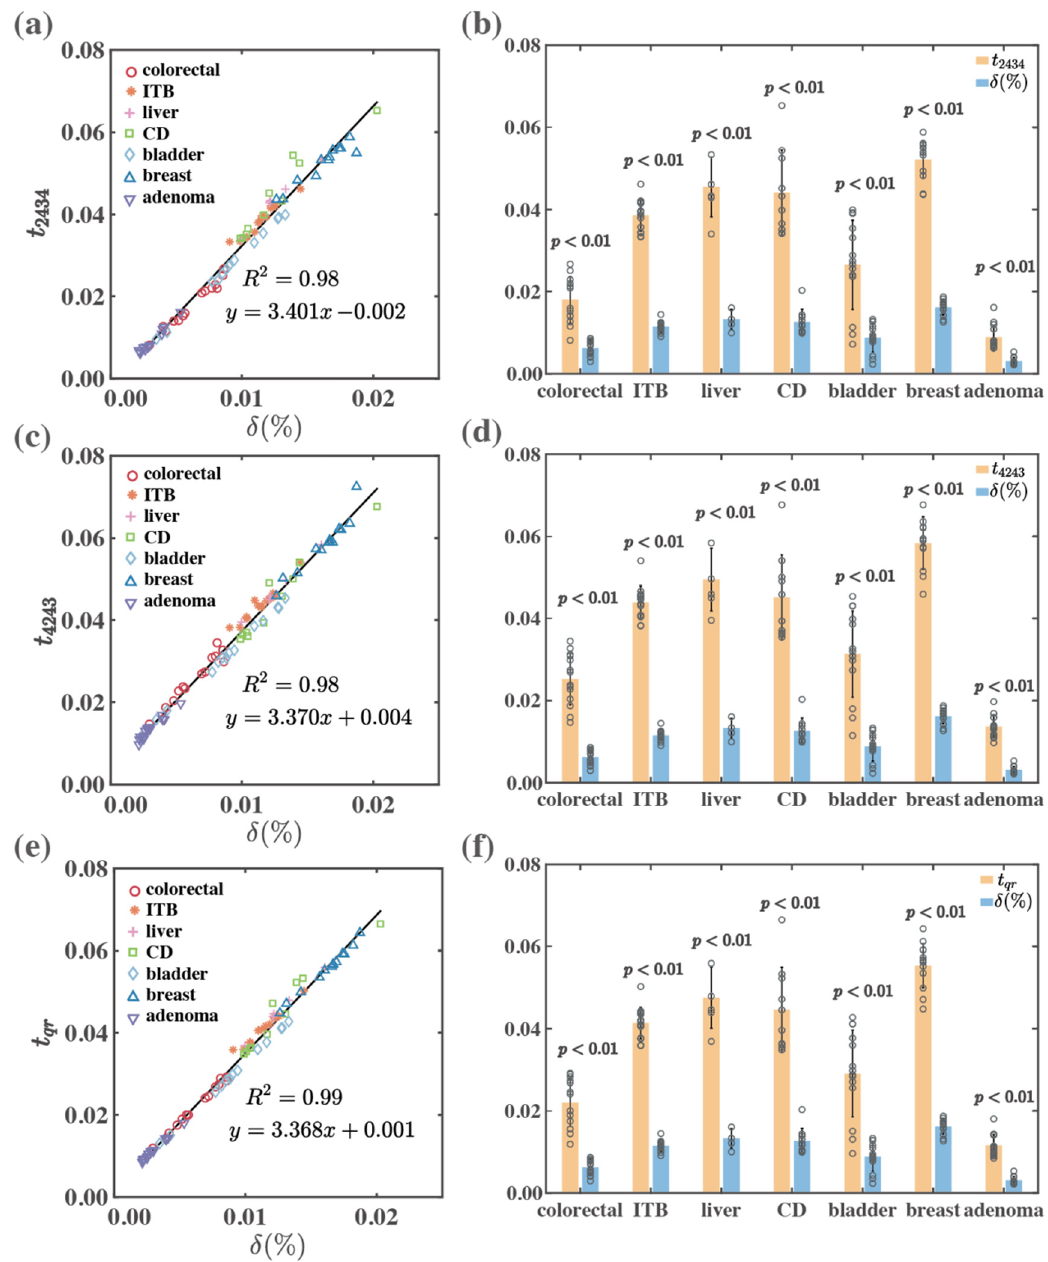
Figure 3. Comparison of MMT and MMPD linear retardance parameters of thin tissue samples. ( a ) Linear retardance MMPD parameter δ plotted against its counterpart MMT parameter t 2434 for correlation analysis with all seven kinds of thin tissue samples. ( b ) Statistical analysis bar chart of linear retardance MMPD parameter δ and MMT parameter t 2434 for each kind of thin tissue samples. ( c ) Linear retardance MMPD parameter δ plotted against its counterpart MMT parameter t 4243 for correlation analysis with all seven kinds of thin tissue samples. ( d ) Statistical analysis bar chart of linear retardance MMPD parameter δ and MMT parameter t 4243 for each kind of thin tissue samples. ( e ) Linear retardance MMPD parameter δ plotted against its counterpart MMT parameter t qr for correlation analysis with all seven kinds of thin tissue samples. ( f ) Statistical analysis bar chart of linear retardance MMPD parameter δ and MMT parameter t qr for each kind of thin tissue sample.